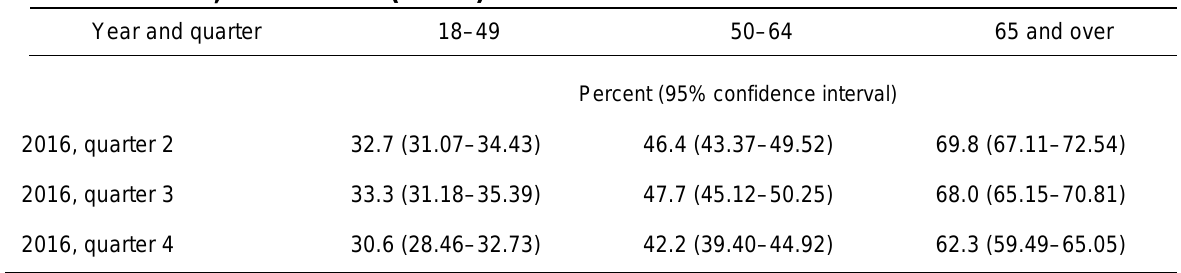
Data table for Figure 4.1. Percentage of adults aged 18 and over who received an influenza vaccination during the past 12 months, by age group and quarter: United States, 1997–2016